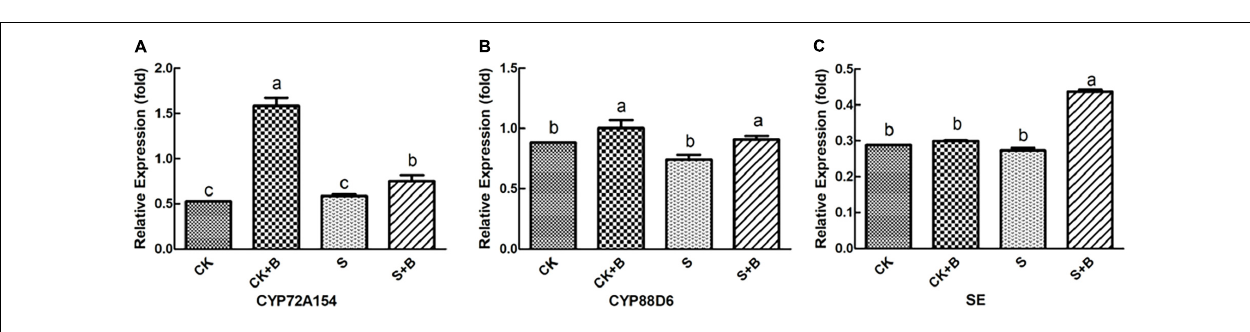
FIGURE 7 | Effect of B. cereus on expression level of (A) CYP72A154, (B) CYP88D6, and (C) SE genes of G. uralensis under control (CK) and salt stress (S) conditions. Data are expressed as the mean ± SE ( n = 6). The different letters within the different treatments indicate the significant difference at P <